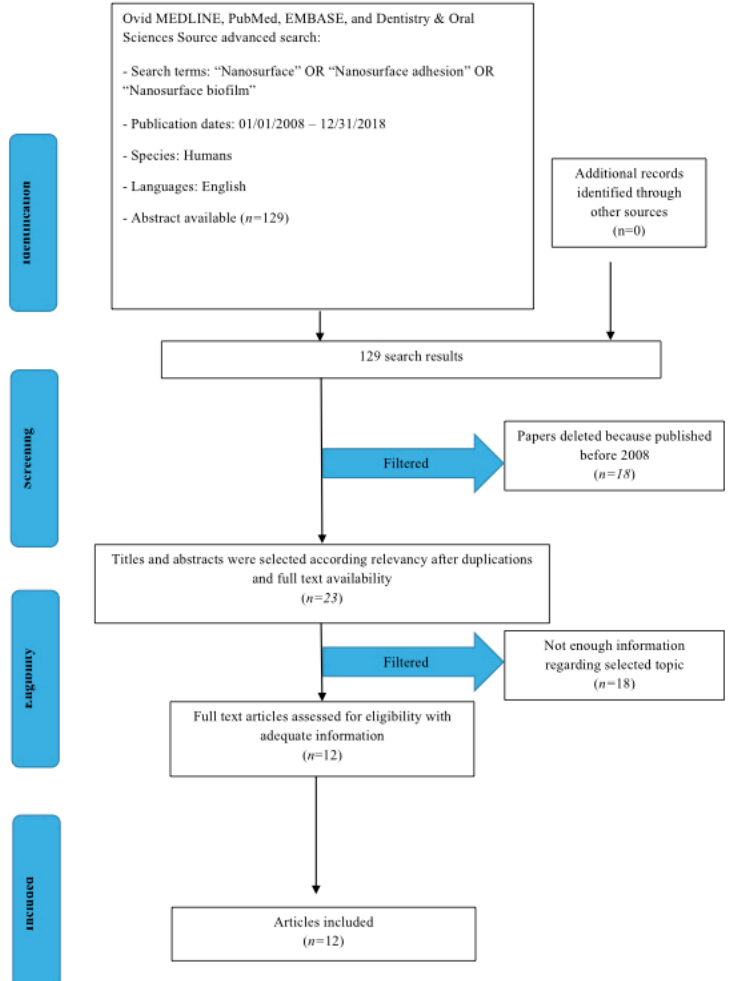
Figure 1. PRISMA flow diagram.